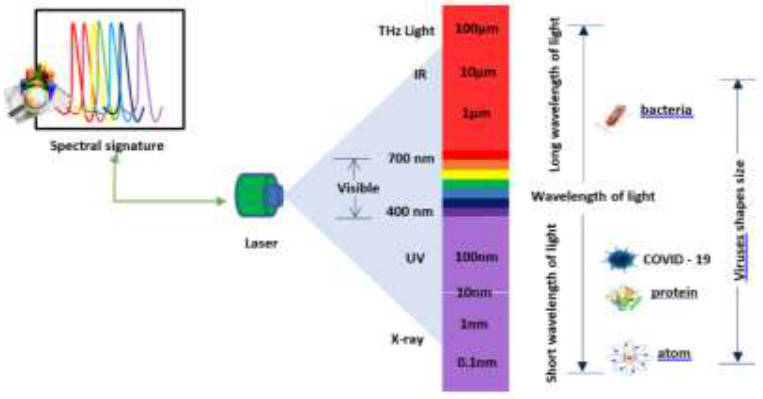
Figure 2 . Comparison of the size of viruses for selecting wavelength suitable used to diagnose COVID – 19